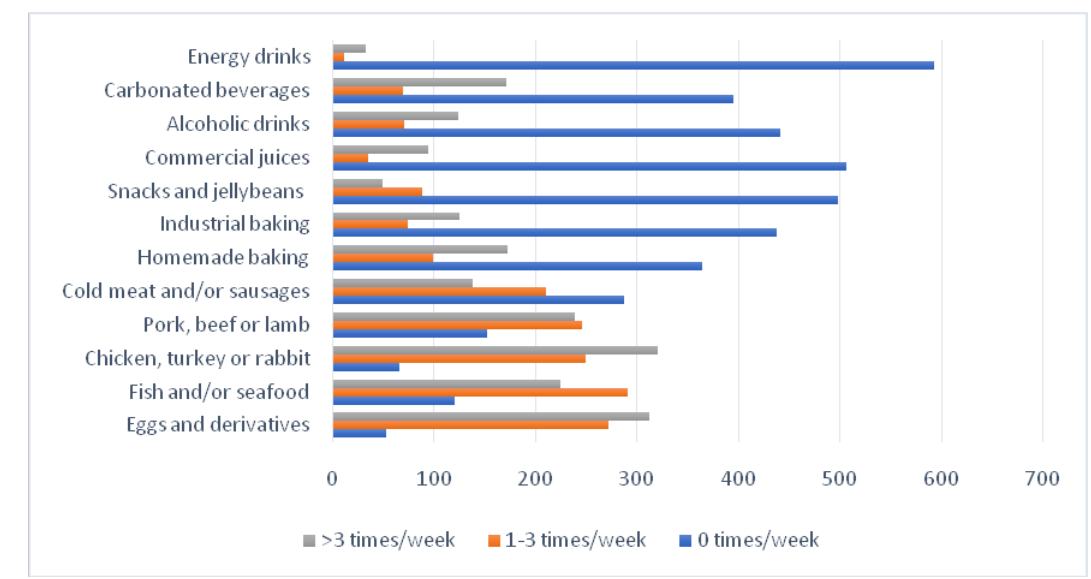
Figure 2. Frequency of consumption. Foods with weekly or occasional recommendations.